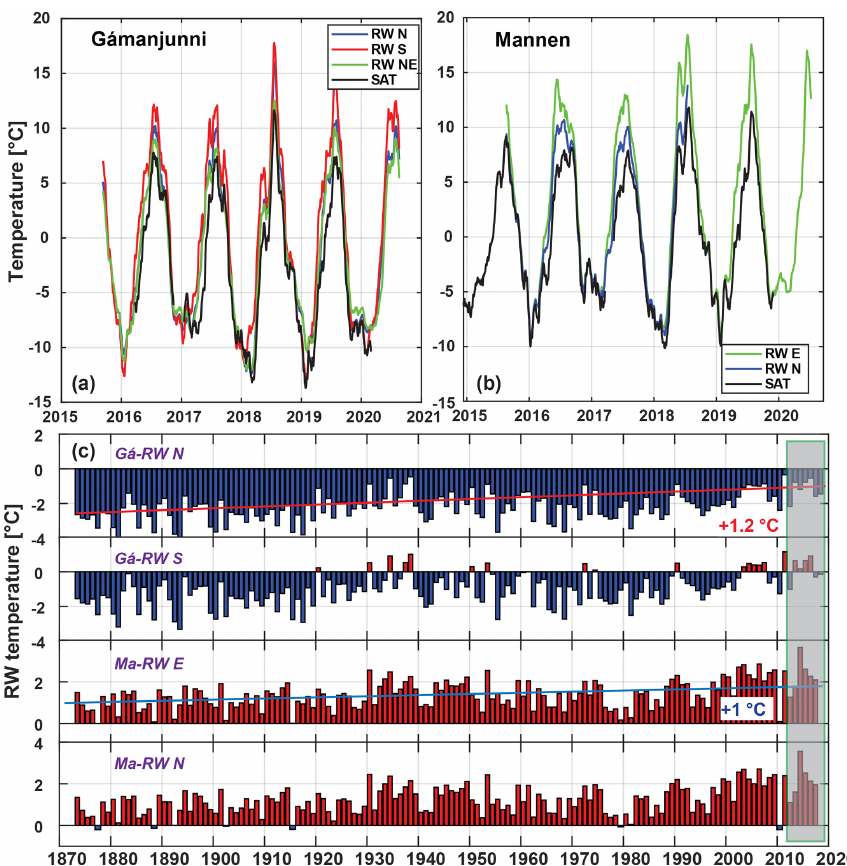
Figure 4. Measured and reconstructed rock wall (RW) surface temperatures and SAT on the plateaus at (a) Gámanjunni-3 and (b) Mannen in different topographic aspects (N: north, for example). The temperature records show the differences in topographic aspect, with higher differences during spring and summer for the different aspects. (c) Reconstructed long-term annual average RW temperature for selected RW loggers at Gámanjunni (Gá) and Mannen (Ma) since 1870. The series show inter-annual variability and increasing mean temperatures of 1 ◦ C or above for the 150-year period. The rockslide and RW temperature monitoring period since 2011 is indicated by the shaded area and denotes some of the highest temperatures during the 150-year